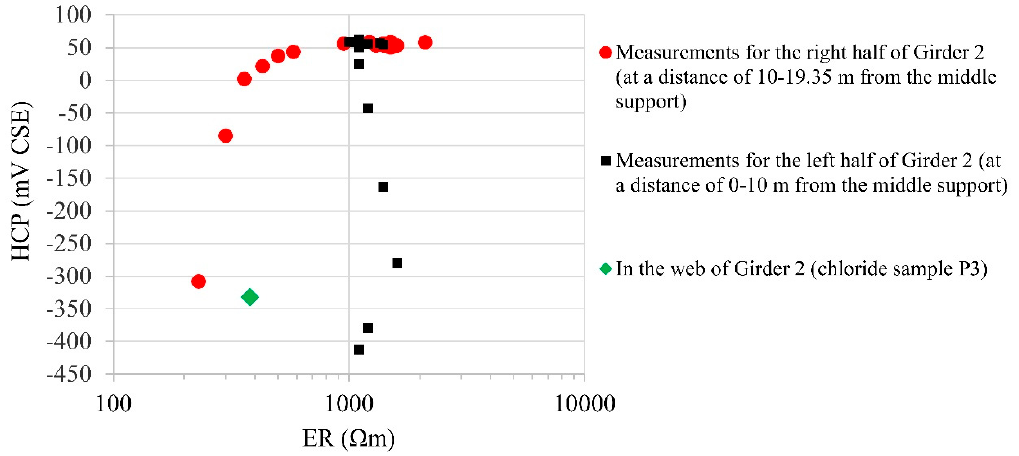
Figure 13. Relationships between HCP and ER measurements.